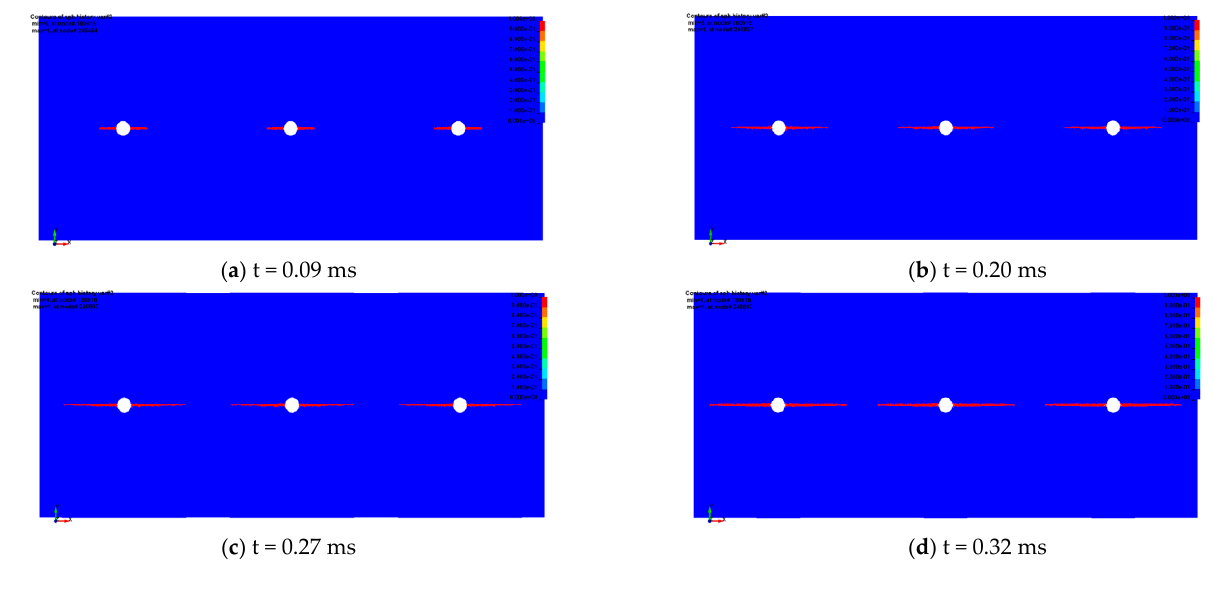
Figure 27. Development process of cracks caused by multi-hole blasting with 600 mm spacing.